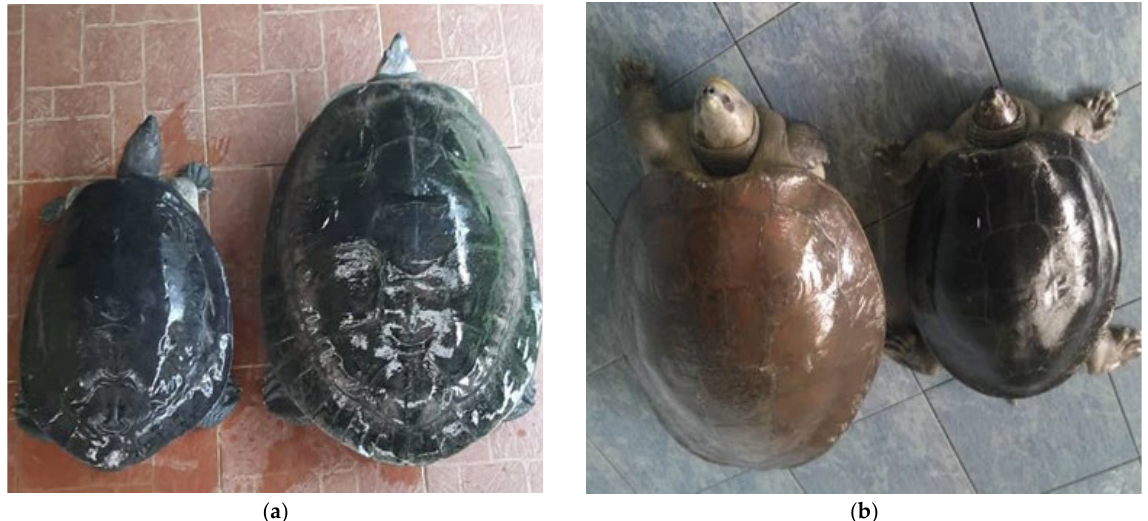
Figure 1. ( a ) Male Batagur affinis affinis (left): The head is noticeably shorter, with a blunt snout and a shorter distance from nostril to the eye; the head is jet black or extremely dark grey, never brownish; and the iris is pristine white throughout the mating season. Female B. a. affinis (right): The head is short and has a blunt snout; the space between the nostrils and the eyes is very short; the head is dark grey or brownish, the jaws are dirty yellow or light brown, and the other soft parts are dark grey or brownish. ( b ) Female B. a. edwardmolli (left): The head is elongated, with a pointed, upturned snout; the head is greyish to brownish, with pale grey to silvery blotches in the temporal and parietal areas, and the jaws are brown. Male B. a. edwardmolli (right): Head and soft parts chocolate brown to almost black; light-colored individuals with brown and never grey skin; lip margins orange; iris golden or bright yellow. dark brown to black carapace [6].